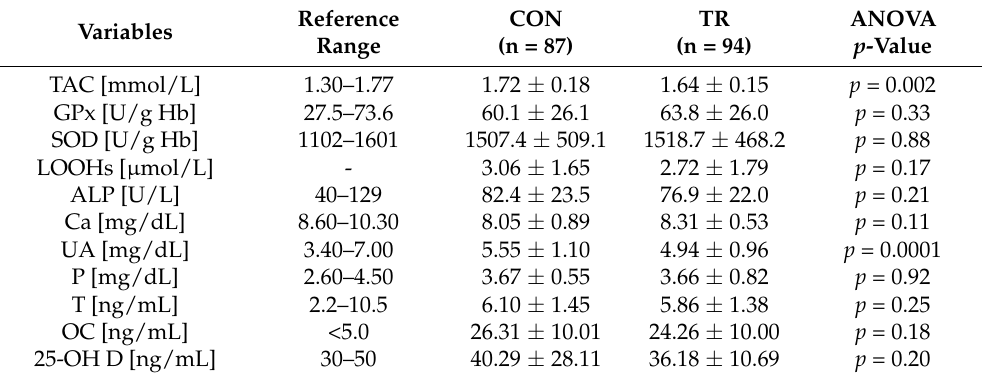
Table 2. Blood levels of biochemical parameters (mean ± SD) in the control group (CON, n = 87) and in the trained group (TR, n = 94).